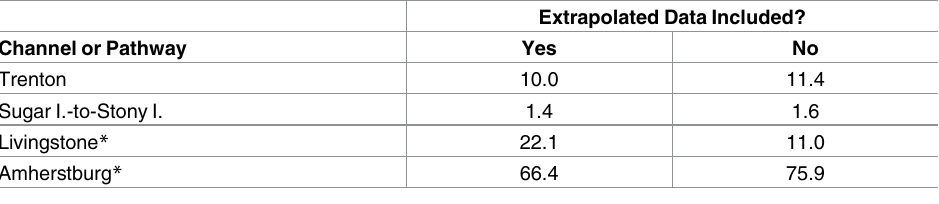
Table 1. Path use (% of observed passages) by acoustic-tagged Lake Sturgeon in the lower Detroit River including and excluding the extrapolated Livingstone channel passage